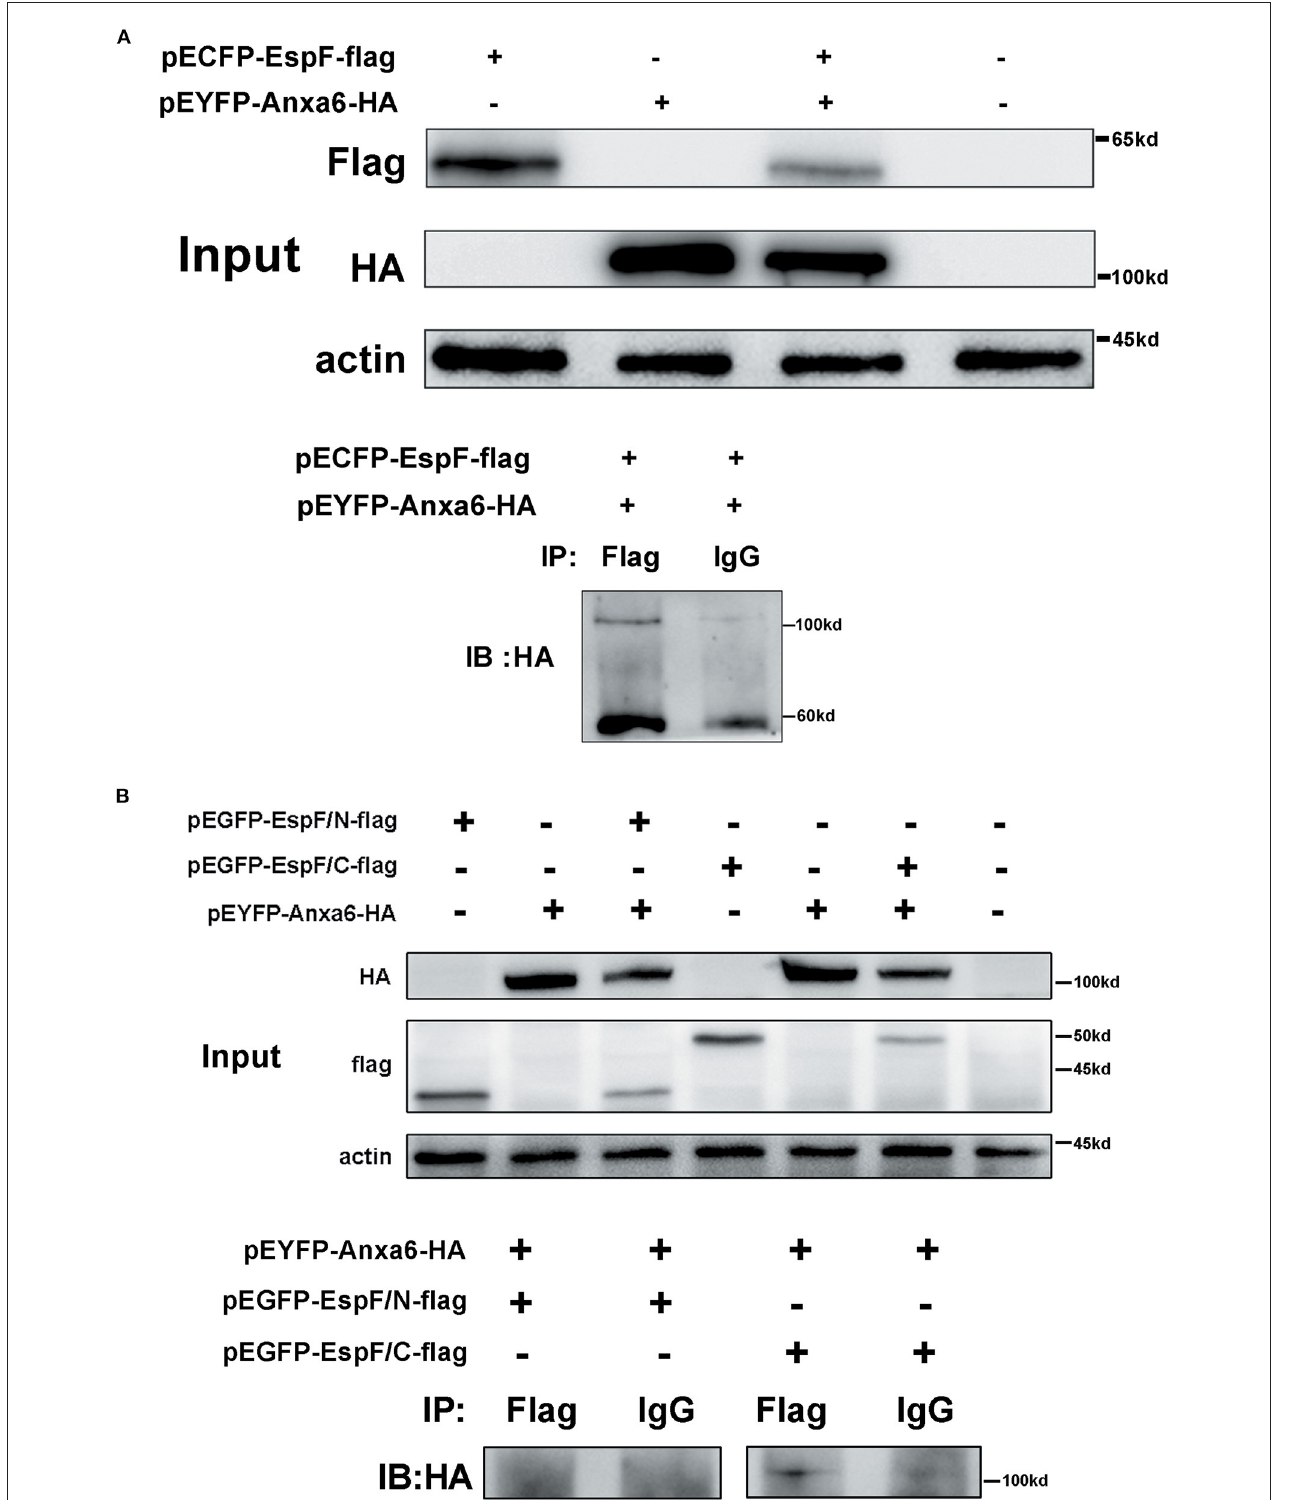
FIGURE 3 | CO-IP confirms the interaction between EspF protein and ANXA6 protein (A) and the specific protein domain of EspF that interacts with ANXA6 (B) . Lysates of HEK293 cells over-expressing EspF or ANXA6, or co-overexpressing EspF and ANXA6, or co-overexpressing EspF/N or EspF/C and ANXA6 were detected by SDS-PAGE and western blotting (Input). The indicated interacting proteins were immunoprecipitated with the indicated antibodies (IB); normal mouse IgG was used as a negative control.